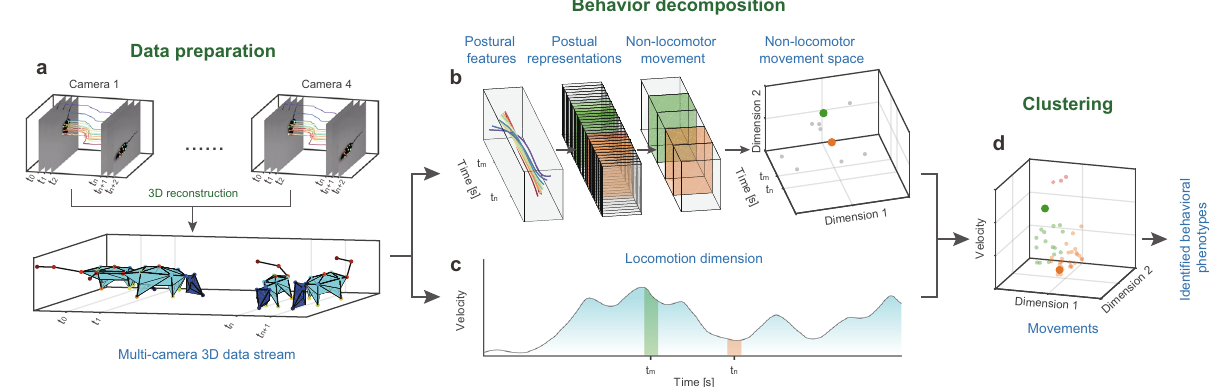
Fig. 1 Hierarchical 3D-motion learning framework for animal behavior analysis. a Data preparation: (1) image streams captured from four cameras with different 2D views; (2) animal body parts are tracked to generates separate 2D skeletal trajectories (color-coded traces); (3) reconstructing 3D body skeleton by integrating these four data streams. b Two-stage NM decomposition to generate the feature space: (1) pose decomposition groups continuous skeleton postural data into discrete postural sequences); (2) NM decomposition, two highlighted (green and orange) blocks represent two NMs decomposed from the postural sequences; (3) NM sequences mapped to their 2D features space (right), where each dot on the 3D axis corresponds to the NM block on the left. c Calculation of locomotion dimension. The continuous velocity of the behaving animal is fi rst calculated, then average the velocity of each segment obtained in the NM decomposition step. d 3D scatter plot represents the combined NM and locomotion feature space. All the movements are clustered into three types (red, green, and orange dots) with the unsupervised